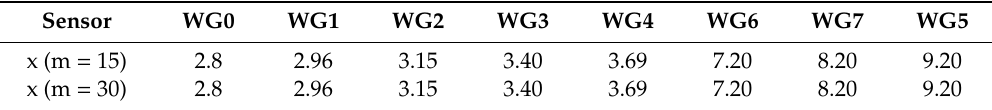
Table 3. Location from paddle of resistive wave gauges (in